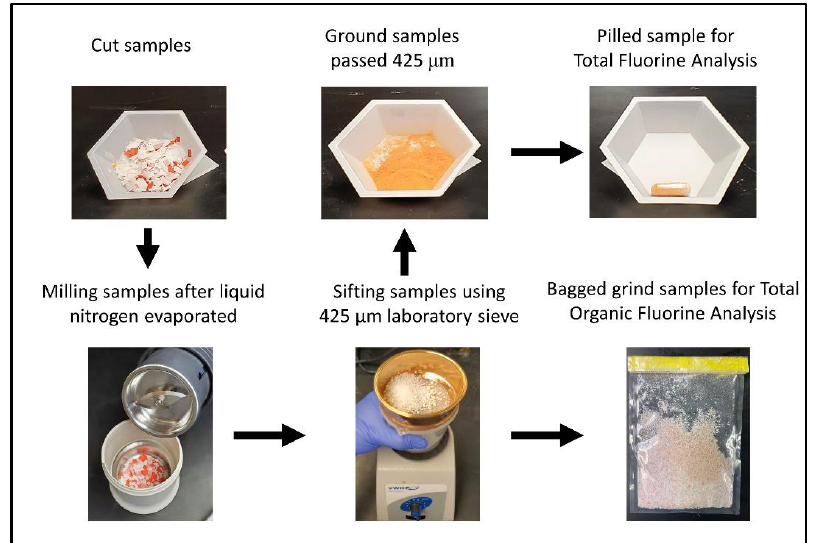
Figure 2. Sample preparation process for measuring total fluorine/total organic fluorine.